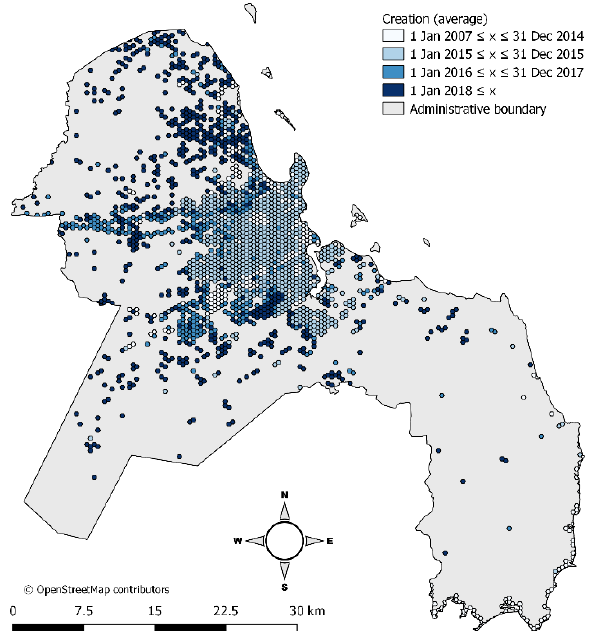
Figure 5. Dar es Salaam grid classified according to the average date of creation of OSM nodes (map data © OpenStreetMap contributors).